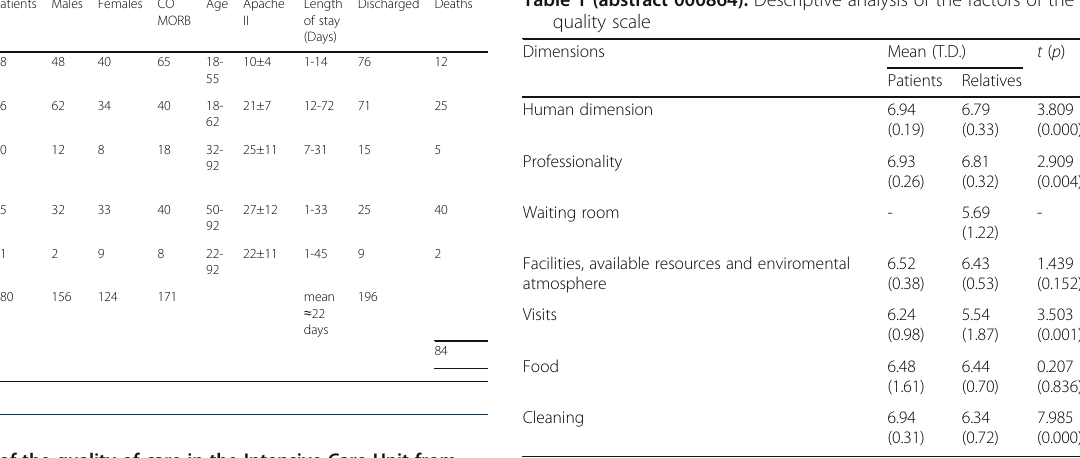
Table 1 (abstract 000843). See text for descriptio Patients Males Females CO Age Apache MORB II